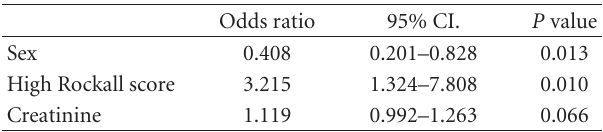
Table 2: Multivariate analysis for rebleeding and nonbleeding